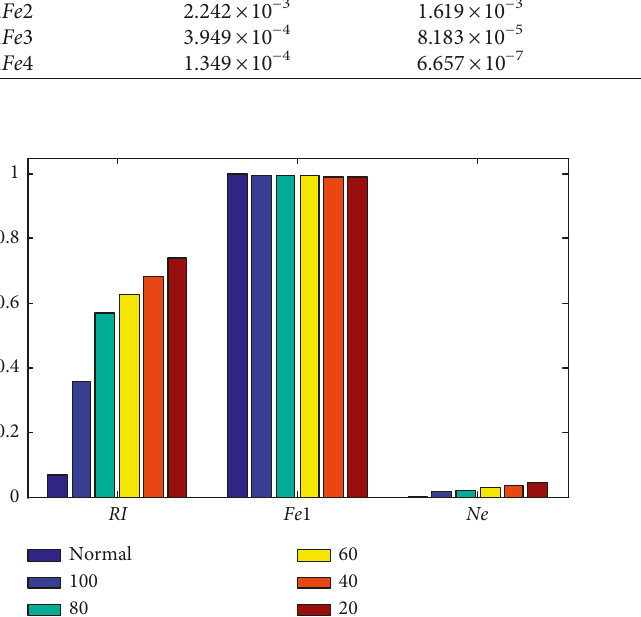
Figure 6: Comparison of simulation results of indexes RI , Fe 1, and Ne under different clearances.